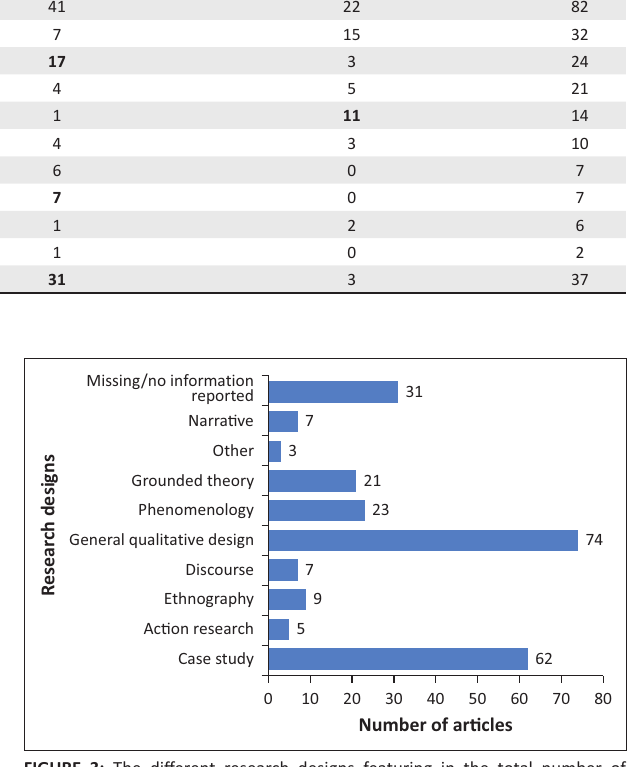
FIGURE 3: The different research designs featuring in the total number of articles ( n =